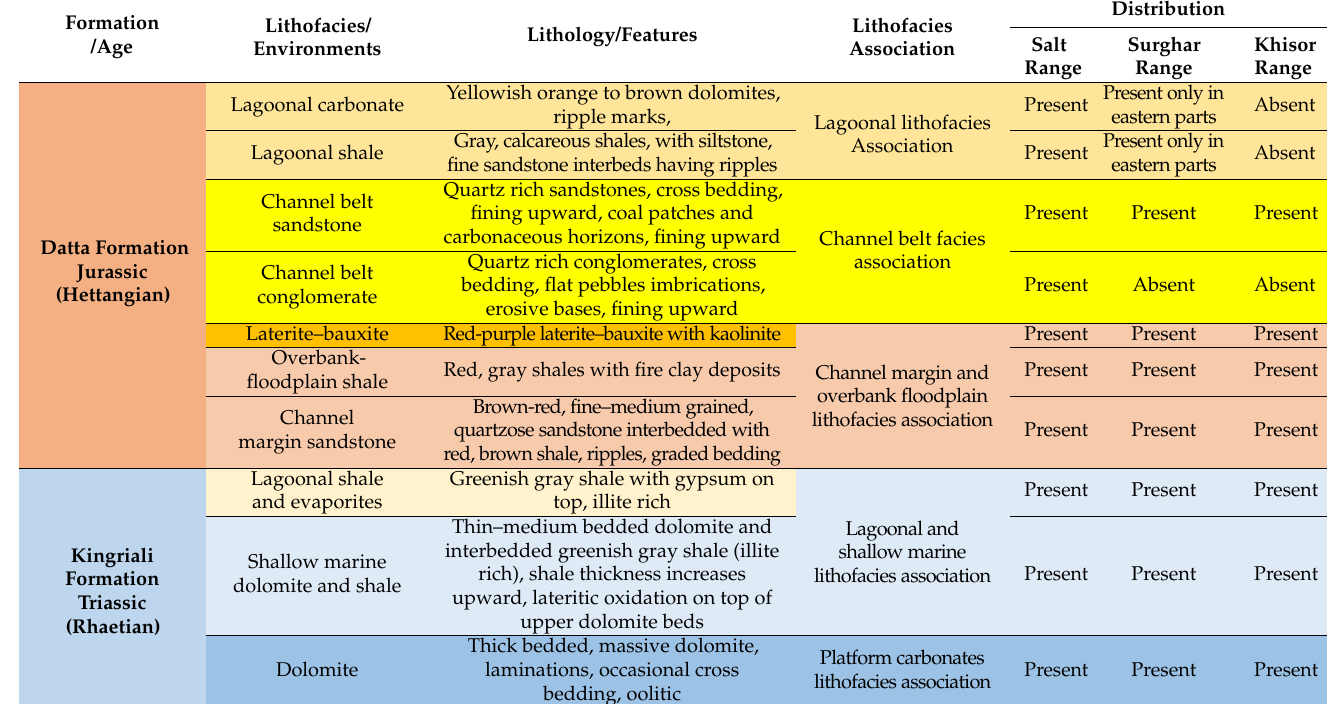
Table 3. Lithofacies and lithofacies associations observed in the Kingriali and Datta formations during the present study. The lithofacies classification is based on their depositional setting. Only the first occurrence in a complete cycle is presented and the lateral distribution in the Salt and Trans–Indus ranges is included in the